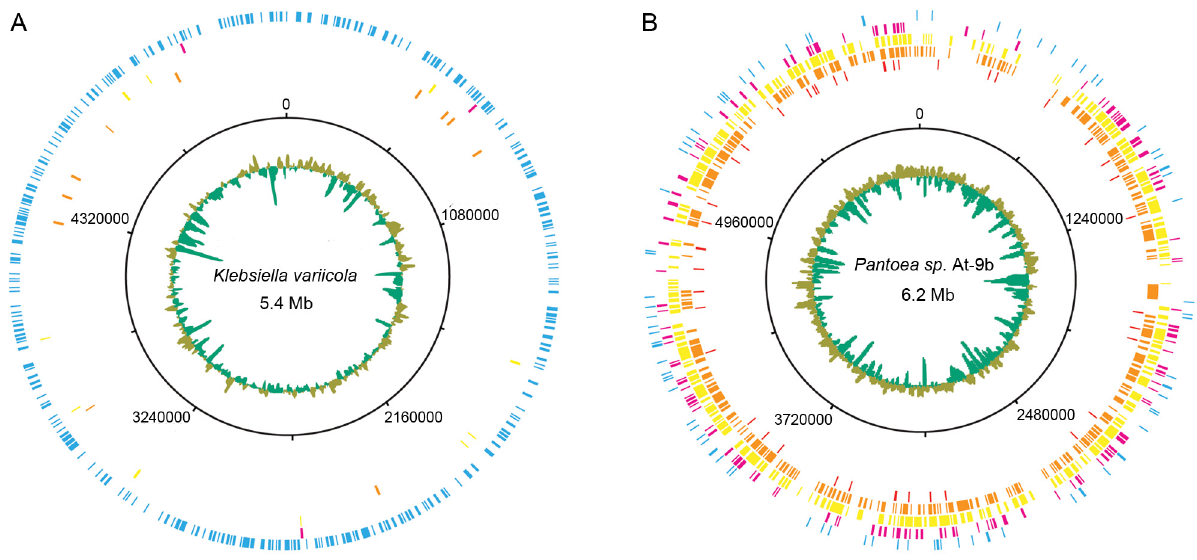
Figure 4. Leaf-cutter ant fungus garden metagenome recruitment analysis. Leaf-cutter ant fungus garden metagenome recruitment analysis. Reads from the leaf-cutter ant fungus garden community metagenome are shown mapped onto the draft genome sequences of the two leaf-cutter ant bacterial symbionts Klebsiella variicola At-22 (A) and Pantoea sp. At-9b (B). The sequence identity of each recruited read is as follows: blue, 95%–100%; magenta, 90%–95%; yellow, 85%–90%; gold, 80%–85%, and red, 75%–80%. The draft genomes are represented as concatenated contigs in order of decreasing size, and the corresponding coordinates are shown in the second-most inner ring. The average GC content for these draft genomes are shown in the innermost ring with green representing above-average GC content, and olive representing below-average GC content.